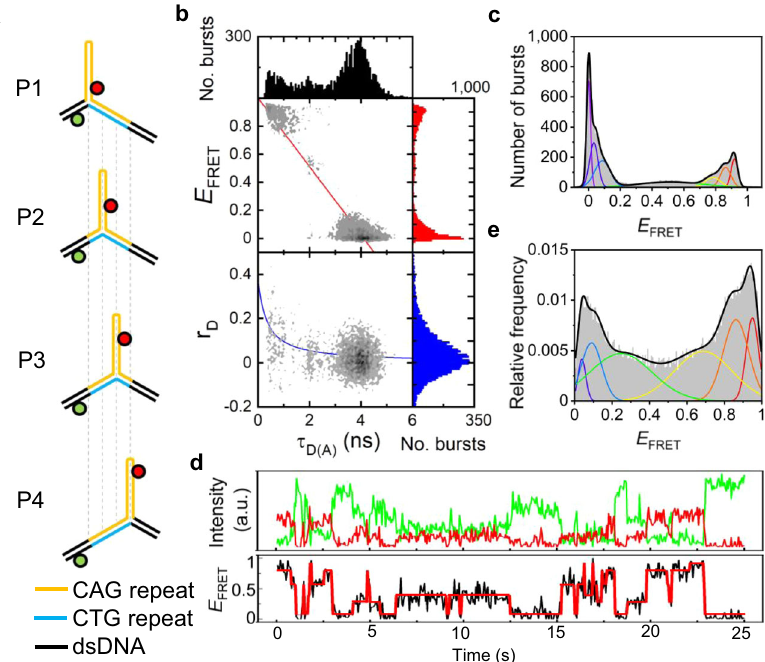
Fig. 2 Interconversion of positional isomers for mobile 3WJs. a The presence of three complementary CAG (orange) and CTG (blue) repeats in the duplex and 10 CAG repeats in the slip-out (orange) could result in four positional isomers P1 – P4. b 2D MFD plot shows FRET ef fi ciency ( E FRET ) or donor anisotropy ( r D ) vs donor lifetime [ τ D(A) ] for freely diffusing 3WJs. c MFD FRET histogram fi ts to six FRET states. d TIRF time traces of surface-immobilized 3WJs; Alexa488 (green) and Cy5 (red) intensities, and calculated FRET ef fi ciency ( E FRET ). e TIRF FRET histogram fi tted to six FRET states. Measured at 20 °C in a buffer containing 1 mM MgCl 2